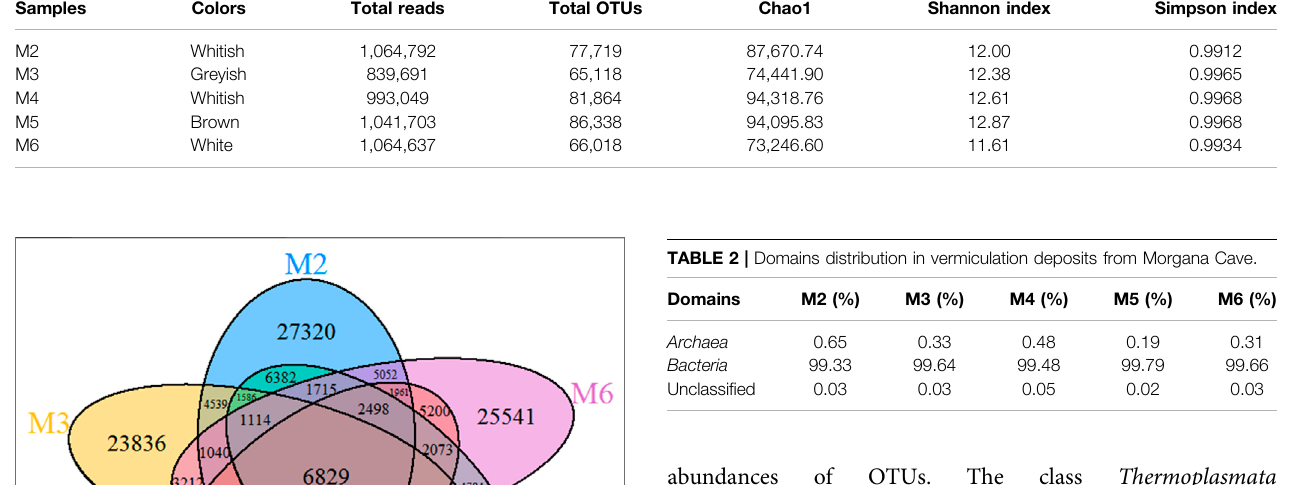
TABLE 1 | Estimation of alpha-diversity indices in vermiculation deposits from Morgana Cave. Samples